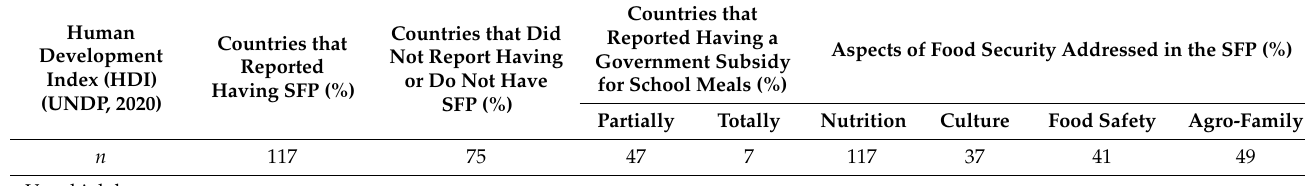
Table 1. Information provided by countries on the presence of a school feeding program (SFP), local government participation in its funding (partial or total subsidy for school feeding), and the presence of nutritional, cultural, food safety, and agro-family aspects in accordance with local human